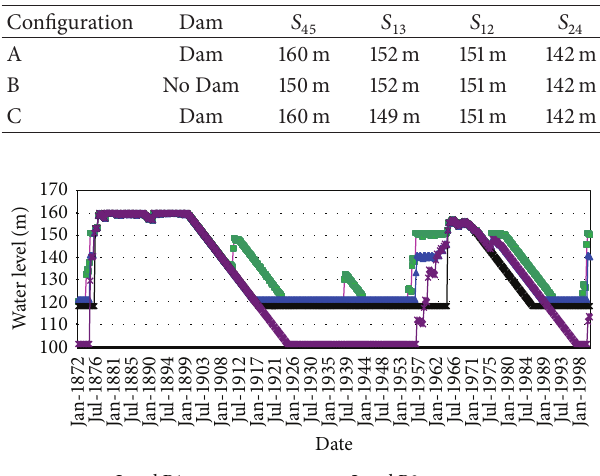
Table 3: Evaporation rates. Table 4: TD configurations A, B, and C.